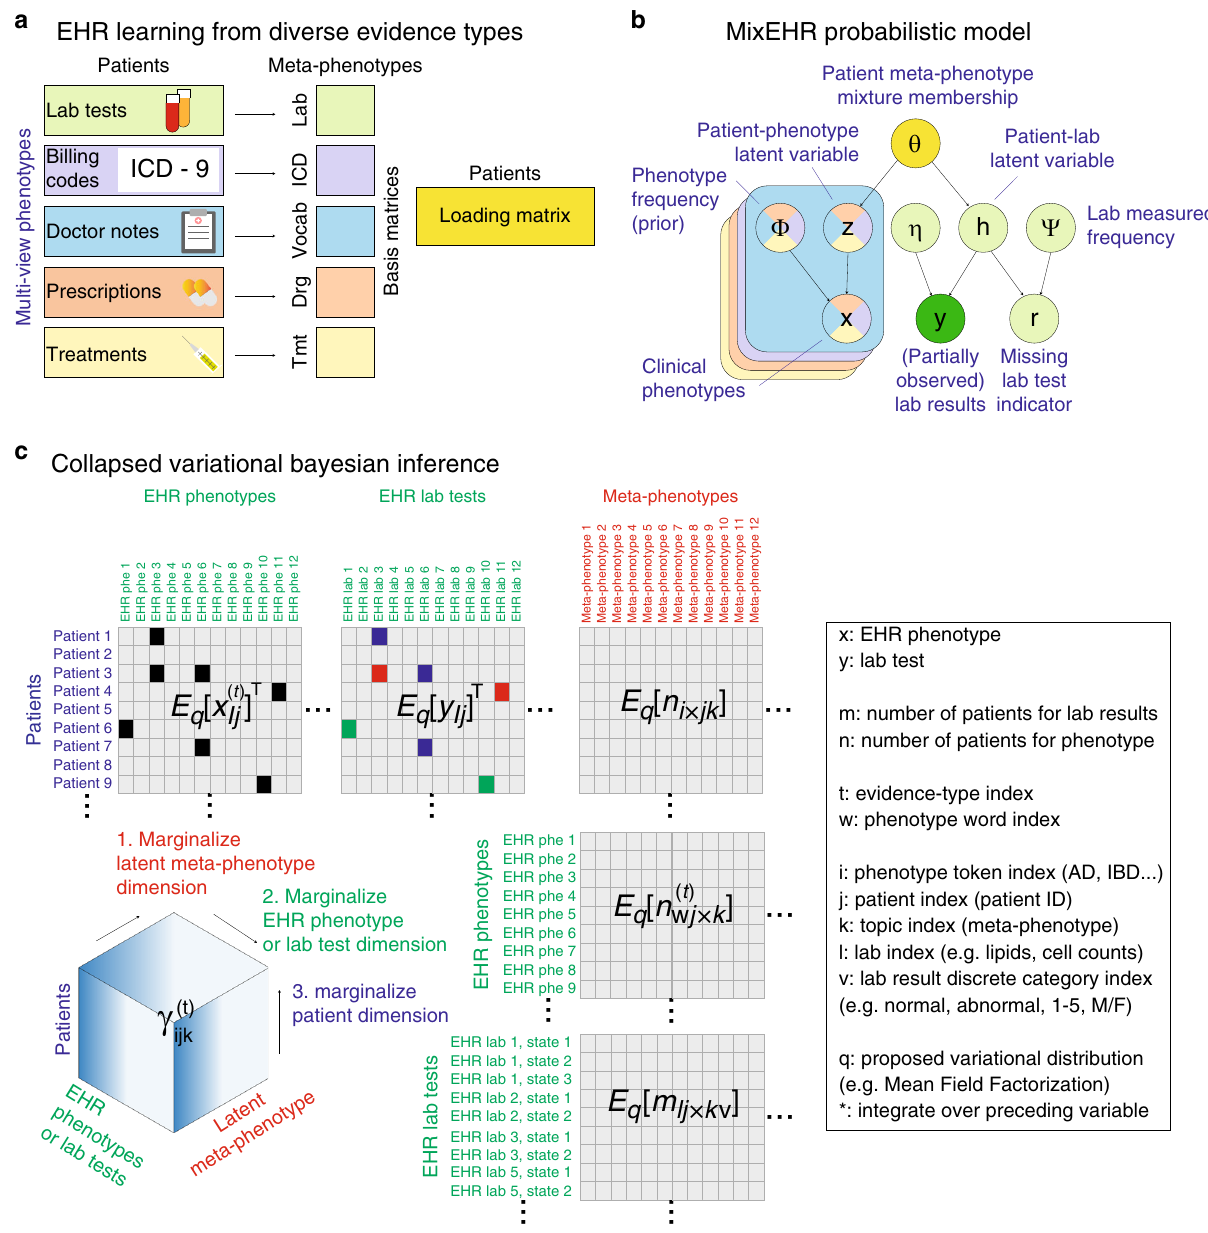
Fig. 1 MixEHR model overview. a Multi-view matrix factorization of multiple data matrices corresponding to different EHR data types, including lab tests, billing code, doctor notes, etc. b Proposed Bayesian model for modeling non-missing-at-random (NMAR) lab tests and other multimodal data. In order to achieve tractable inference, we assign a latent topic h lj to the lab results y lj and missing indicator ( r lj ) such that they become conditionally independent. c Collapsed variational Bayesian inference of the MixEHR model. The inference and learning can be visualized as marginalizing a three-dimensional tensor that represents the expectations of the latent